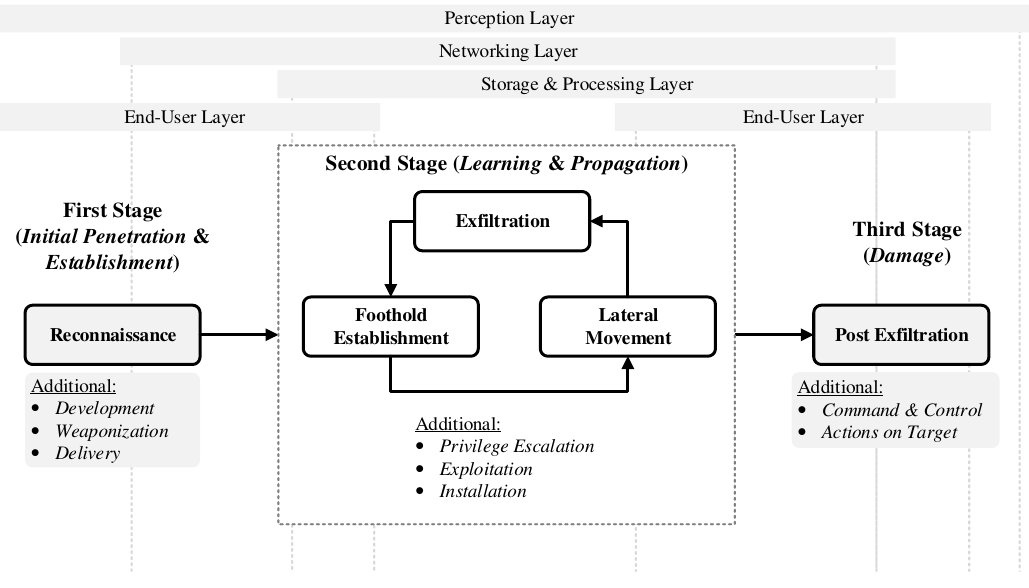
Figure 1. Advanced persistent threat (APT) attack stages (adapted from [8,38–40]), where some stages may have concurrent/parallel steps. The APT stages may be supplemented with additional steps/procedures to compensate for emerging technologies and defense mechanisms [38,39]. The boundary between physical and virtual layers may also be crossed between the APT stages, depending on the attack behaviors and target system